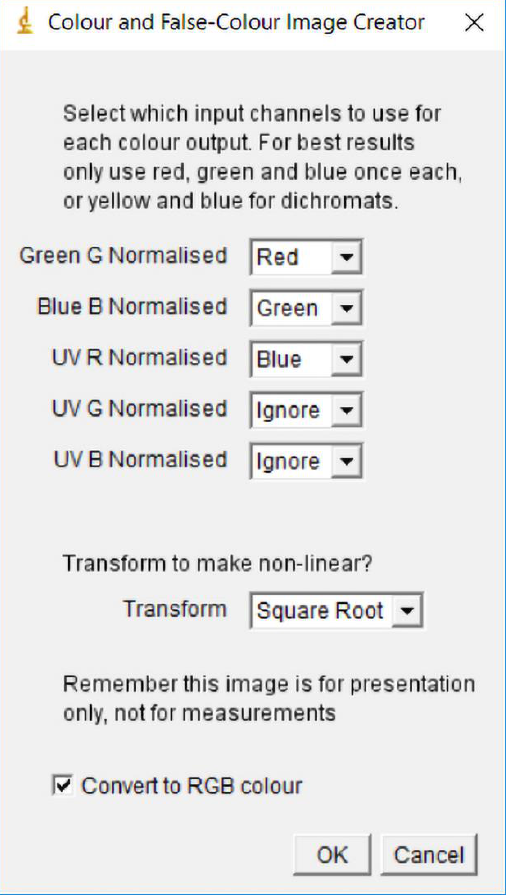
F IGURE 12. Dialogue box to select that the green channel from the picture taken with the green filter becomes the new red channel, blue channel from the picture taken with the blue filter becomes green and the red channel from the picture taken with the UV filter becomes